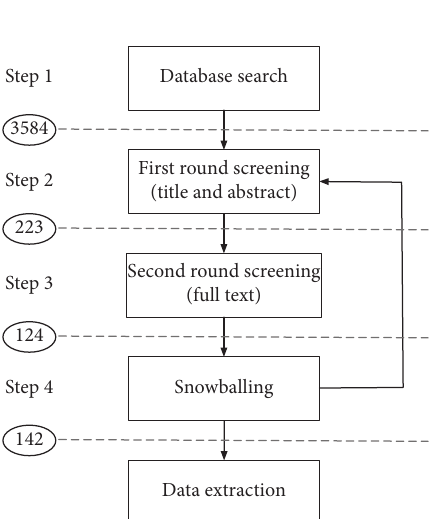
Figure 3: Formal search and selection